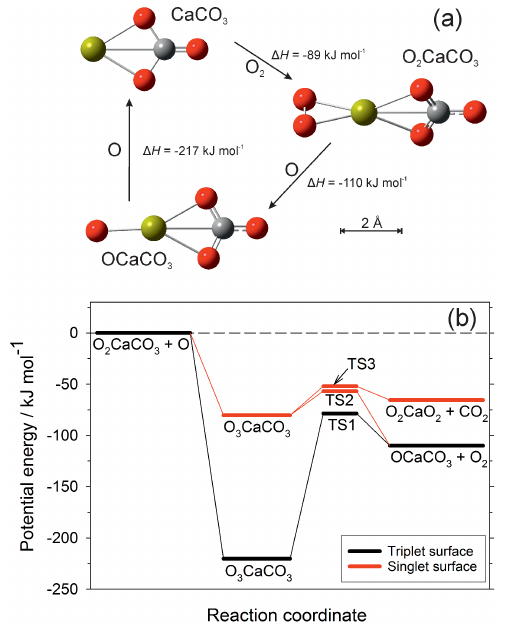
Figure 2. (a) The CaCO 3 holding cycle, analogous to that of CaOH (Gómez-Martín and Plane, 2017). Colour scheme: Ca (yellow), C (grey), O (red). The reaction enthalpies (at 0K) for each step were calculated at the B3LYP/6-311 + g(2d,p) level of theory (Frisch et al., 2009). (b) Potential energy surface for the reaction between O 2 CaCO 3 and O, calculated at the B3LYP/6-311 + g(2d,p) level of theory. Zero-point energies are included in the energies of the sta- tionary points. The quintet surface for this reaction is